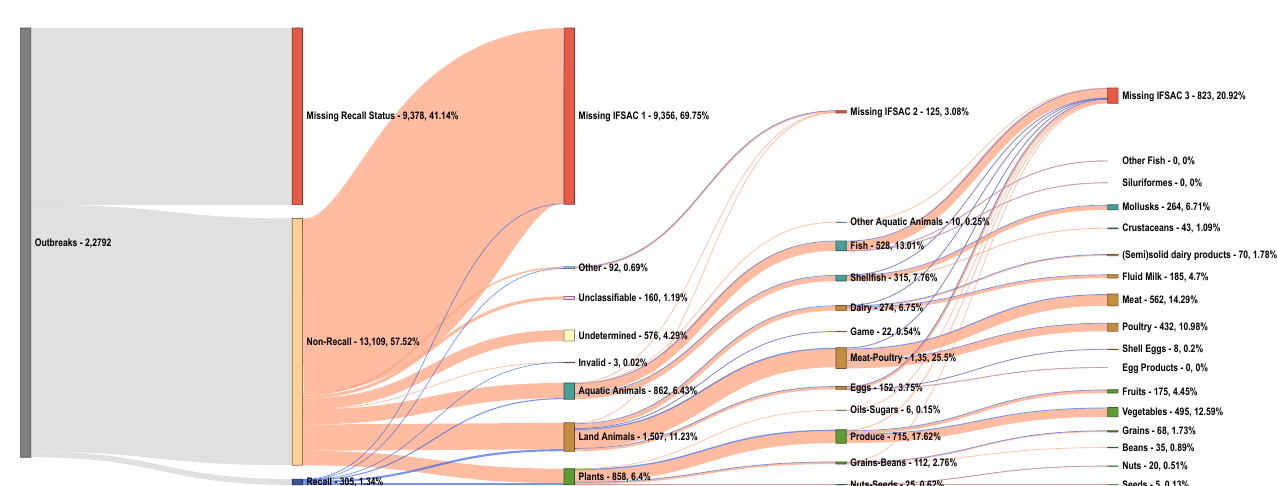
Figure 4. A Sankey Diagram of a sub-analysis examining the distribution of recalls with and with- out missing information across the Interagency Food Safety Analytics Collaboration (IFSAC) food categorization for Levels 1–3. We report frequencies and percentages of foodborne and waterborne outbreaks associated with each category for all 22,792 outbreaks reported by the electronic Foodborne Outbreak Reporting System (eFORS) and National Outbreak Reporting System (NORS) in 1998–2019. Blue and orange colors define outbreaks with non-missing and missing recall status information, respectively. We calculated percentages according to the frequency of observations in each level. Level 1 describes overarching food groups, including aquatic animals, land animals, plants, and other foodstuffs. Level 2 further categorizes groups into fish/shellfish, other aquatic animals, dairy, game, meat/poultry, eggs, oils/sugars, produce, grains/beans, and seeds/nuts. Level 3 provides more refined categories by specific food